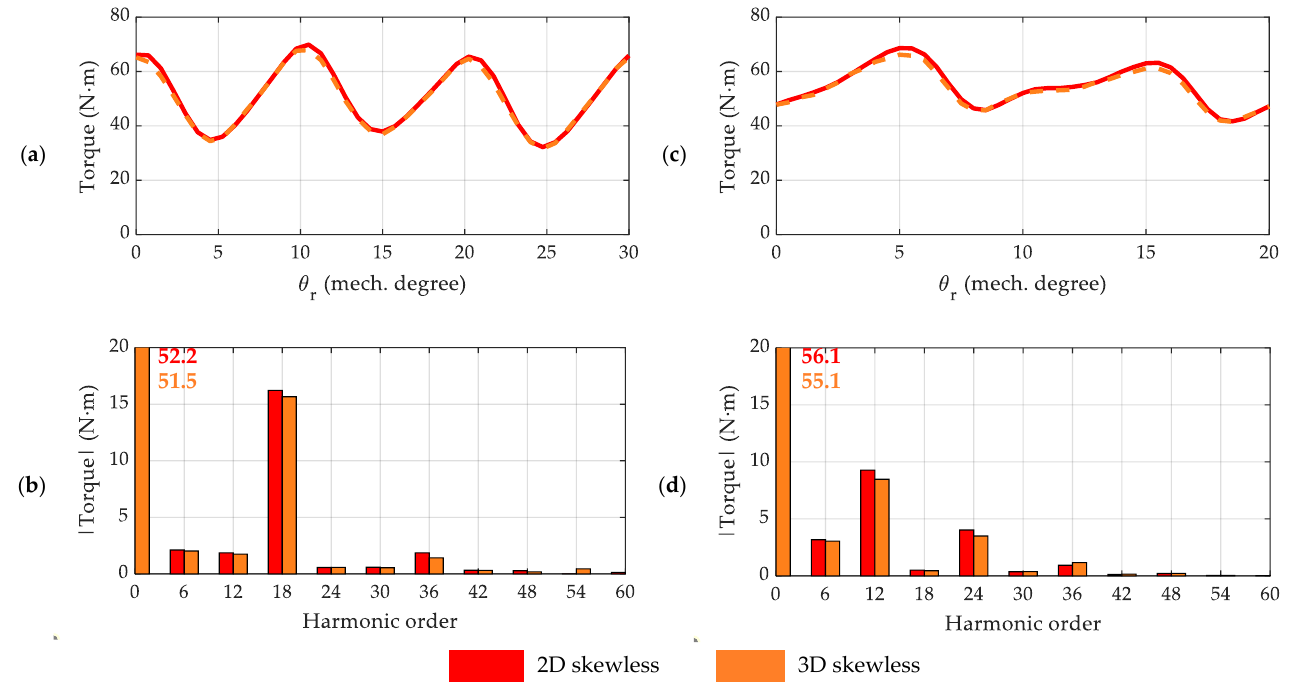
Figure 5. Electromagnetic torque waveform and spectrum of a skewless reference machine: ( a ) torque waveform of four-pole machine with two barriers per pole; ( b ) torque spatial harmonic content of four-pole machine with two barriers per pole; ( c ) torque waveform of six-pole machine with two barriers per pole; ( d ) torque spatial harmonic content of six-pole machine with two barriers per pole. Additionally, 2D and 3D simulation results are